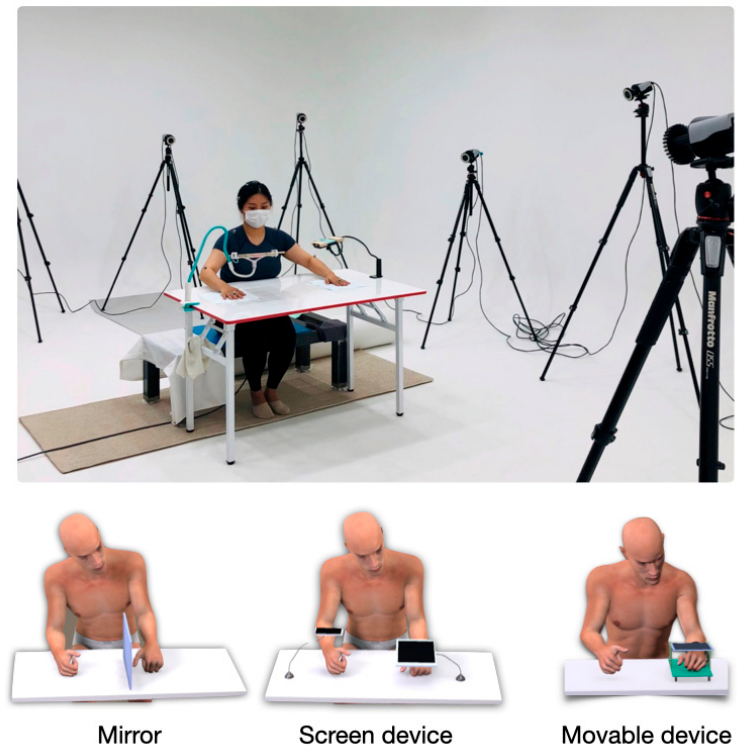
Figure 1. The top image demonstrates the experimental environment. Images below show the de- vices used for the three different conditions (mirror, screen,